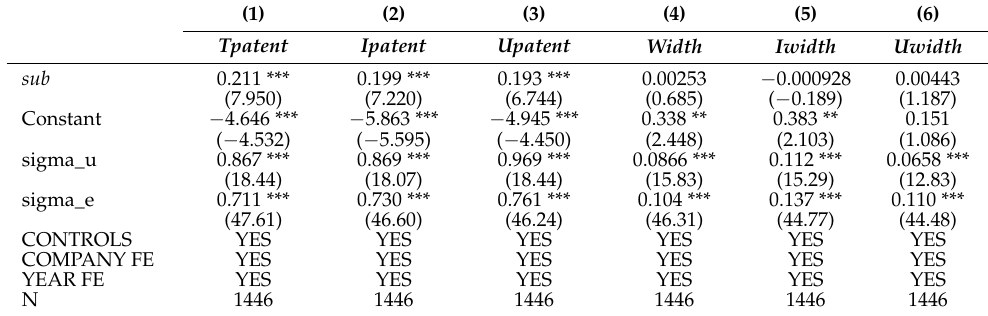
Table 8. Robustness test: Panel Tobit